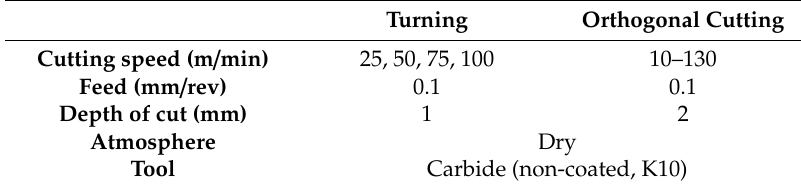
Figure 1. Schematic of an orthogonal cutting. Table 1. Cutting conditions (turning